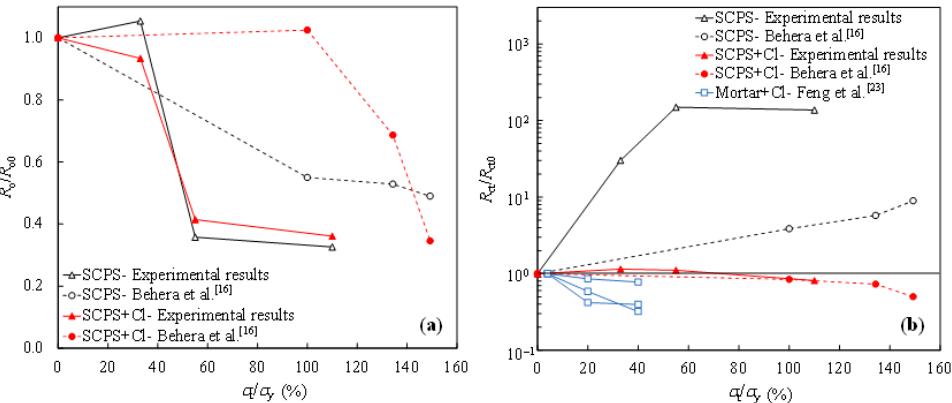
Figure 7. Ratio of the resistance under tensile-stressed conditions to non-stressed condition with